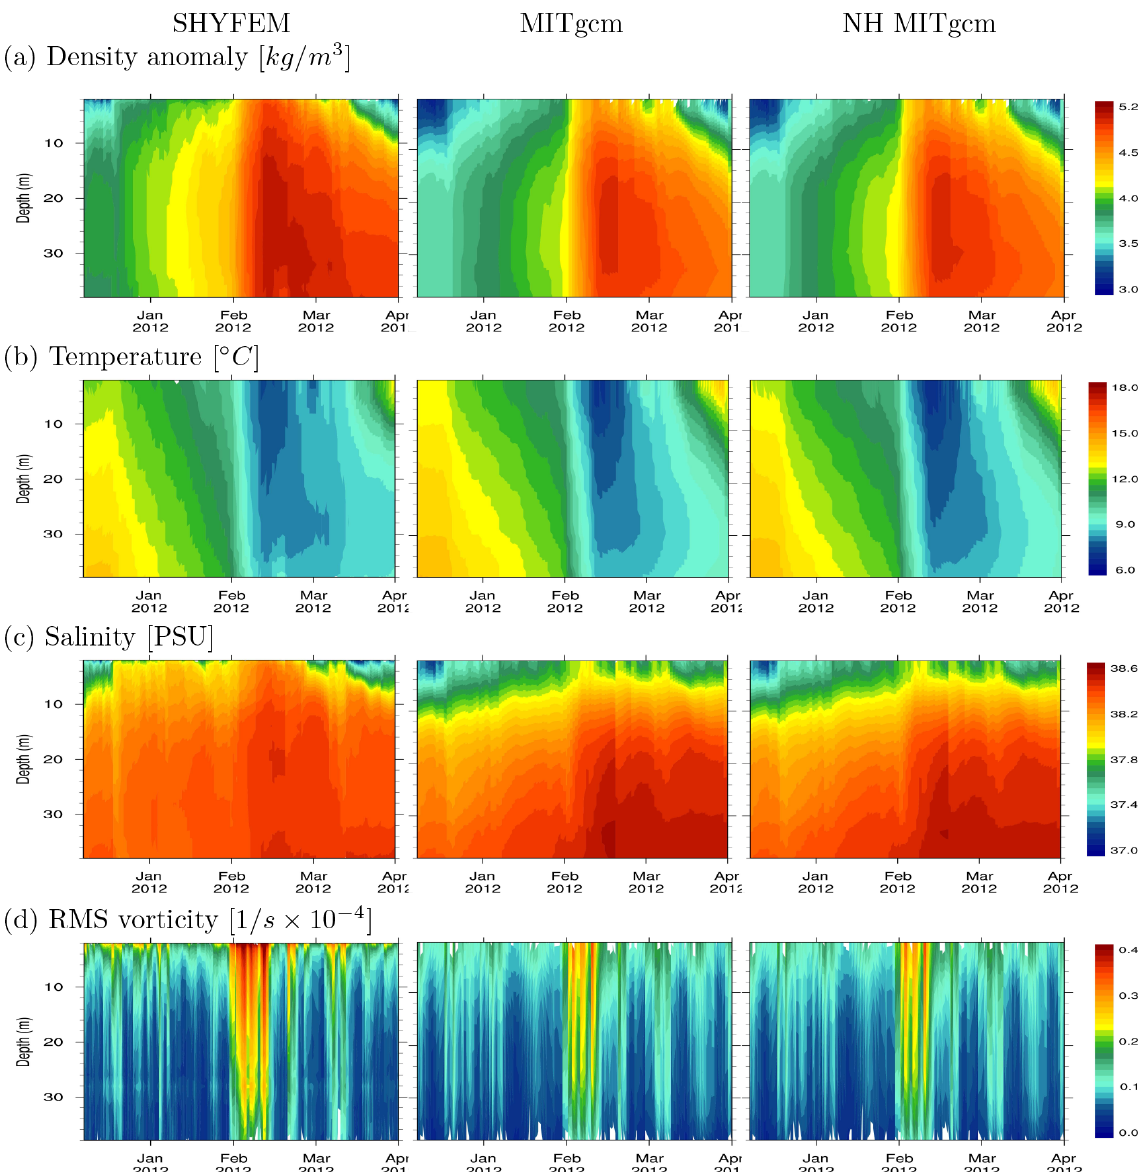
Figure 7. Time series of depth profiles of the (a) density anomaly, (b) temperature, (c) salinity, and (d) RMS of vorticity averaged over the north Adriatic area, for SHYFEM and MITgcm, both in the hydrostatic and nonhydrostatic